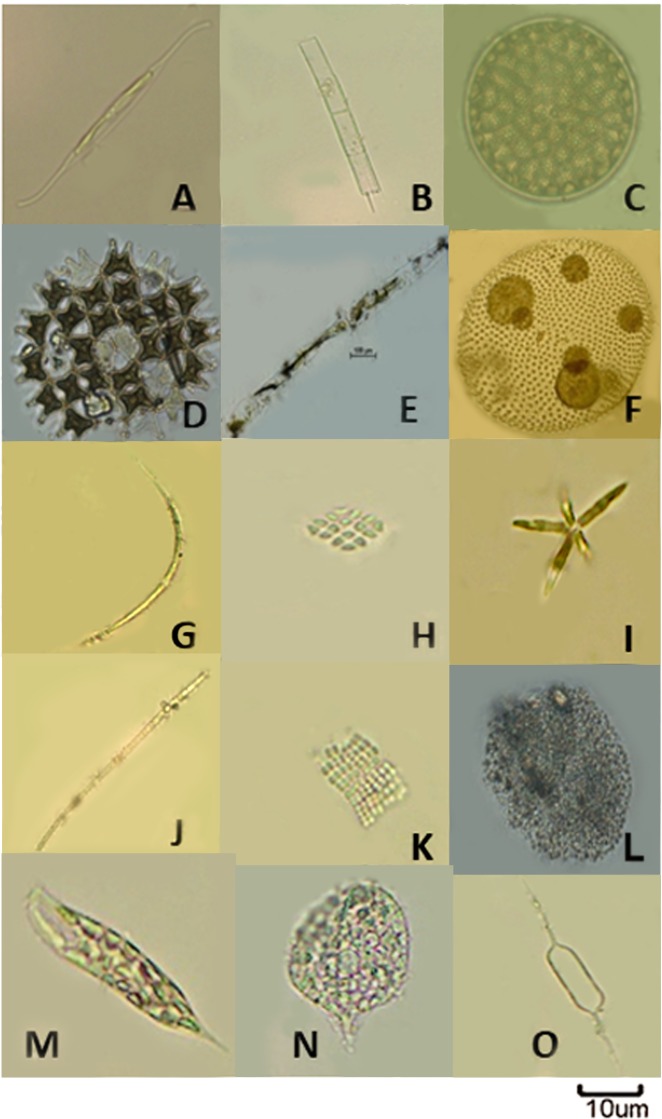
Phytoplankton diversity—Bacillariophyta (A-C); Chlorophyta (D-I); Cyanobacteria (J-L); Euglenophyta (M-N); Ochrophyta (O). Species in details: A. Nitzschiareversa
B.Aulacoseiragranulata
C.Thalassiosira sp. D.Pediastrum duplex
E.Mougeotiasp. F.Volvox sp. G.Closteriopsis sp. H. Crucigenia sp. I.Actinastrum sp. J.Anabaena sp. K.Merismopedia sp. L. Microcystis sp. M.Euglena sp. N.Phacus sp. O.Centritractus sp.